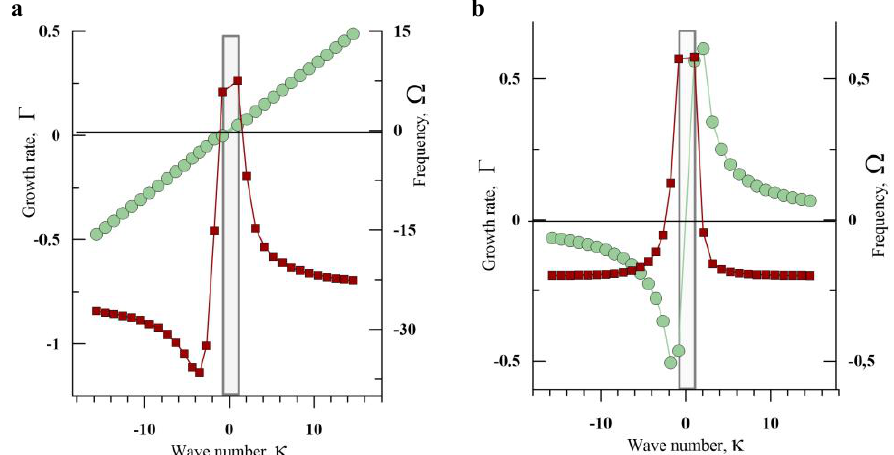
Fig. 2. Dependences of the normalized growth rates,  , (squares) and frequency shifts  , (curcles) of hot modes of a combined cavity with length 3 L  , reflection factor 0.1 R  and DFB parameter 2 b  on normalized wave number,  . (а) Electromagnetic waves in the case of an inverted active medium with strong inhomogeneous broadening of a spectral line, 1   , and low relaxation rate of a polarization, 0.02   , when two modes with 3.7 E с T   became unstable (the polariton modes decay and not 2 shown). (b) Polariton modes in the case of an inverted active medium with weak inhomogeneous broadening of a spectral line, 0.1   , and low relaxation rate of a polarization, modes with ~ 3 T  becames unstable (electromagnetic modes decay and not E с